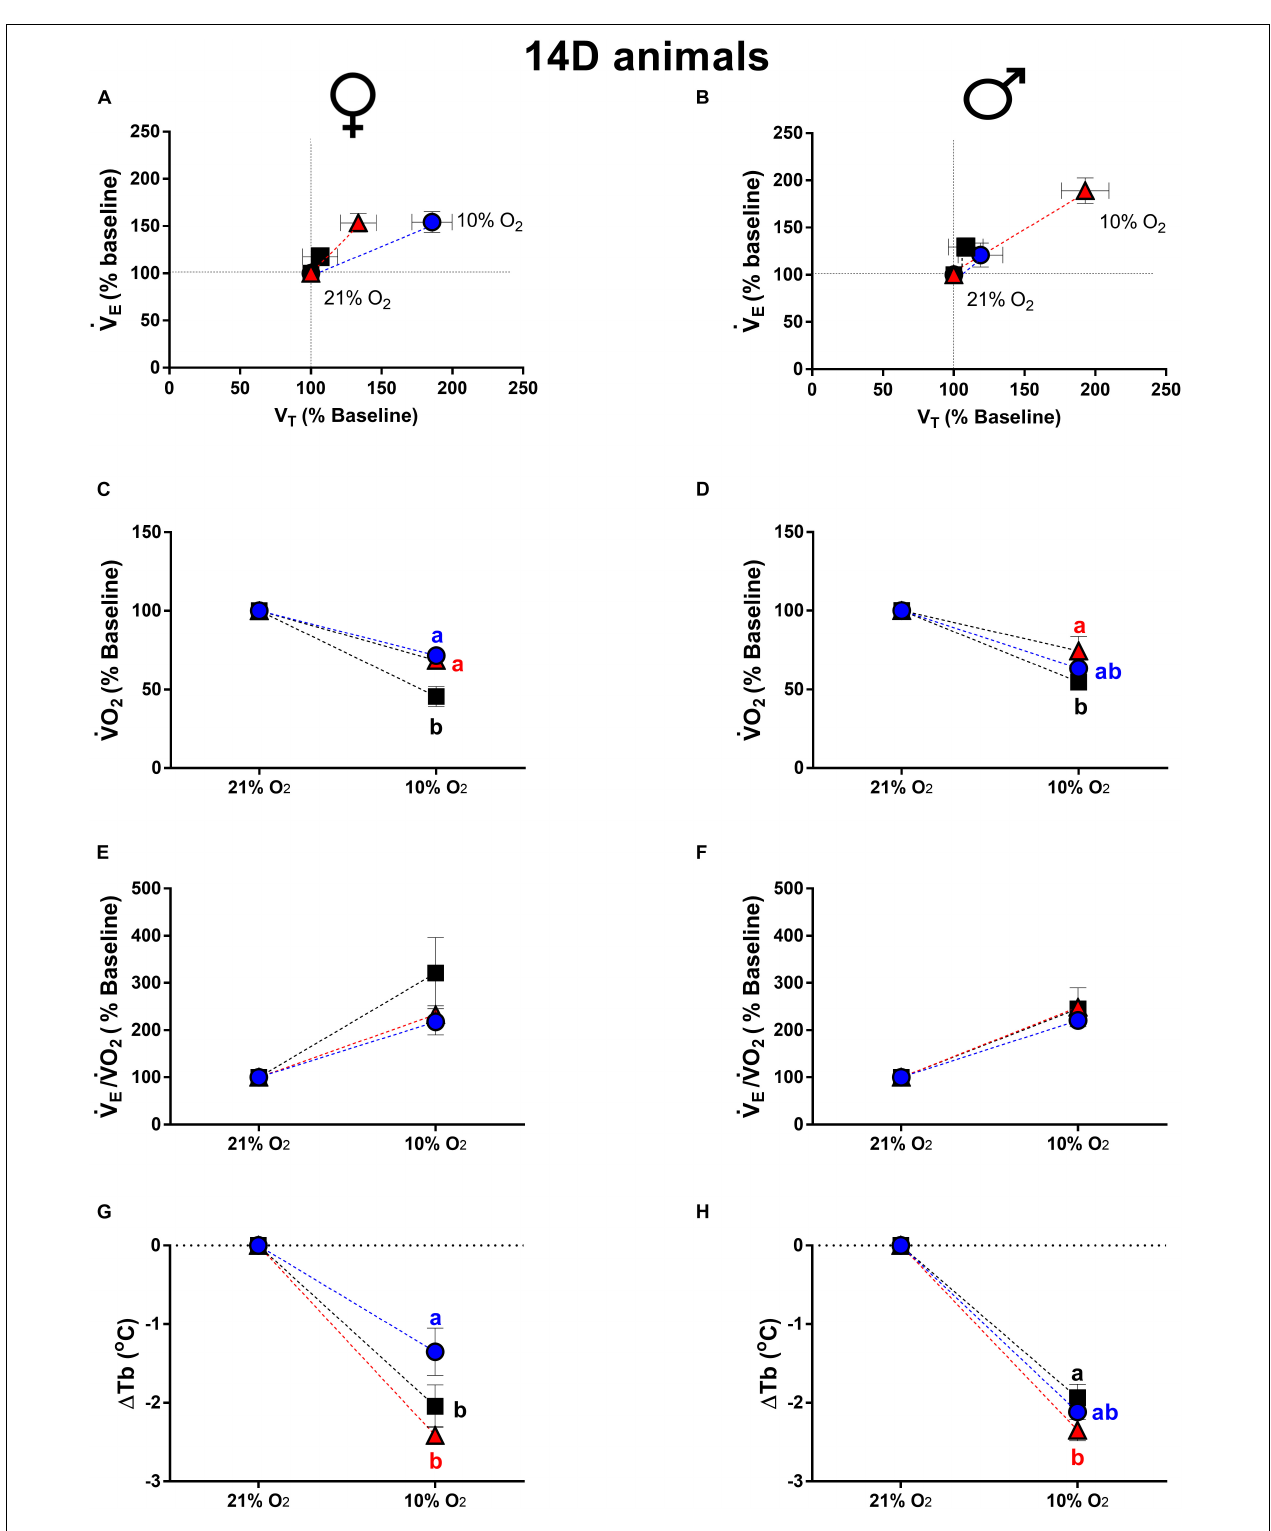
FIGURE 4 | Breathing pattern (A,B) , oxygen consumption ( ˙ V O 2 ) (C,D) , air convection requirement ( ˙ V E / ˙ V O 2 ) (E,F) and body temperature (Tb) (G,H) , during normoxia and hypoxia of 14-days-old female and male broiler chicks submitted to the experimental treatments during incubation, i.e., control temperature (CT, 37.5 ◦ C), low temperature (LT, 36 ◦ C, 6 h/day, from 0 to 5th day) and high temperature (HT, (39 ◦ C, 6 h/day, from 0 to 5th day). Values are expressed as mean ± SEM. Different letters represent statistical differences among the treatments. Level of significance: P ≤ 0.05.